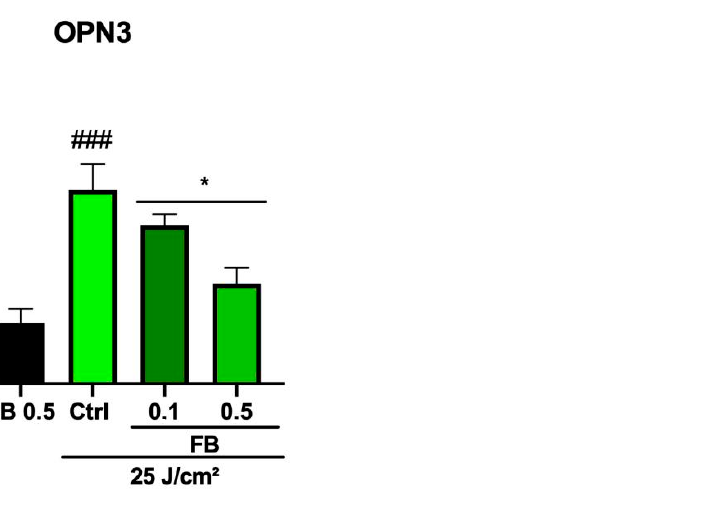
Figure 6. Opsin-3 (OPN3) expression in melanocytes exposed to artificial blue light and the treat- ments. Data show different expression levels of OPN3 in control, irradiated, and FB-treated mela- nocytes. Cells were incubated in phenol red-free DMEM 1% FBS with FB for 24 h before irradia- tion (25 J/cm 2 ) and OPN3 expression was quantified 48 h after by RT-PCR. Data are shown as mean ± SEM. ### p < 0.001 vs. control; * p < 0.1 vs. irradiated.